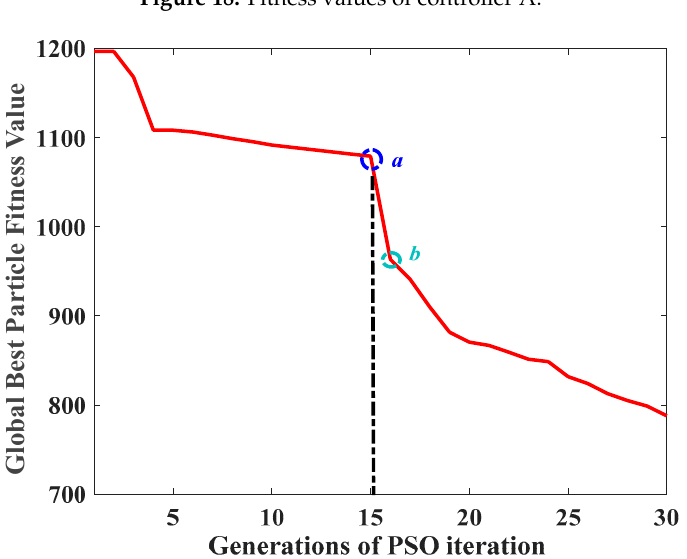
Figure 19. Fitness values of controller B.